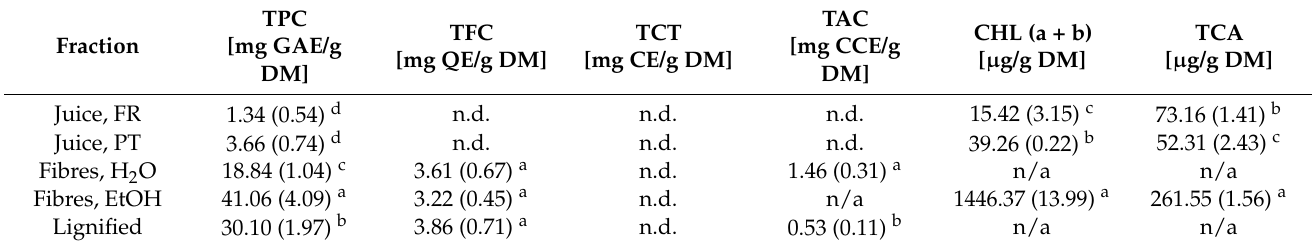
Table 3. Bioactive compounds in S. ramosissima fractions. TPC: total phenolic compounds [mg GAE/g DM] ( p < 0.001), TFC: total flavonoids [mg QE/g DM] ( p = 0.240), TCT: total condensed tannins [mg CE/g DM], TAC: total anthocyanidins [mg CCE/g DM] ( p < 0.001), CHL: total chlorophyll [ µ